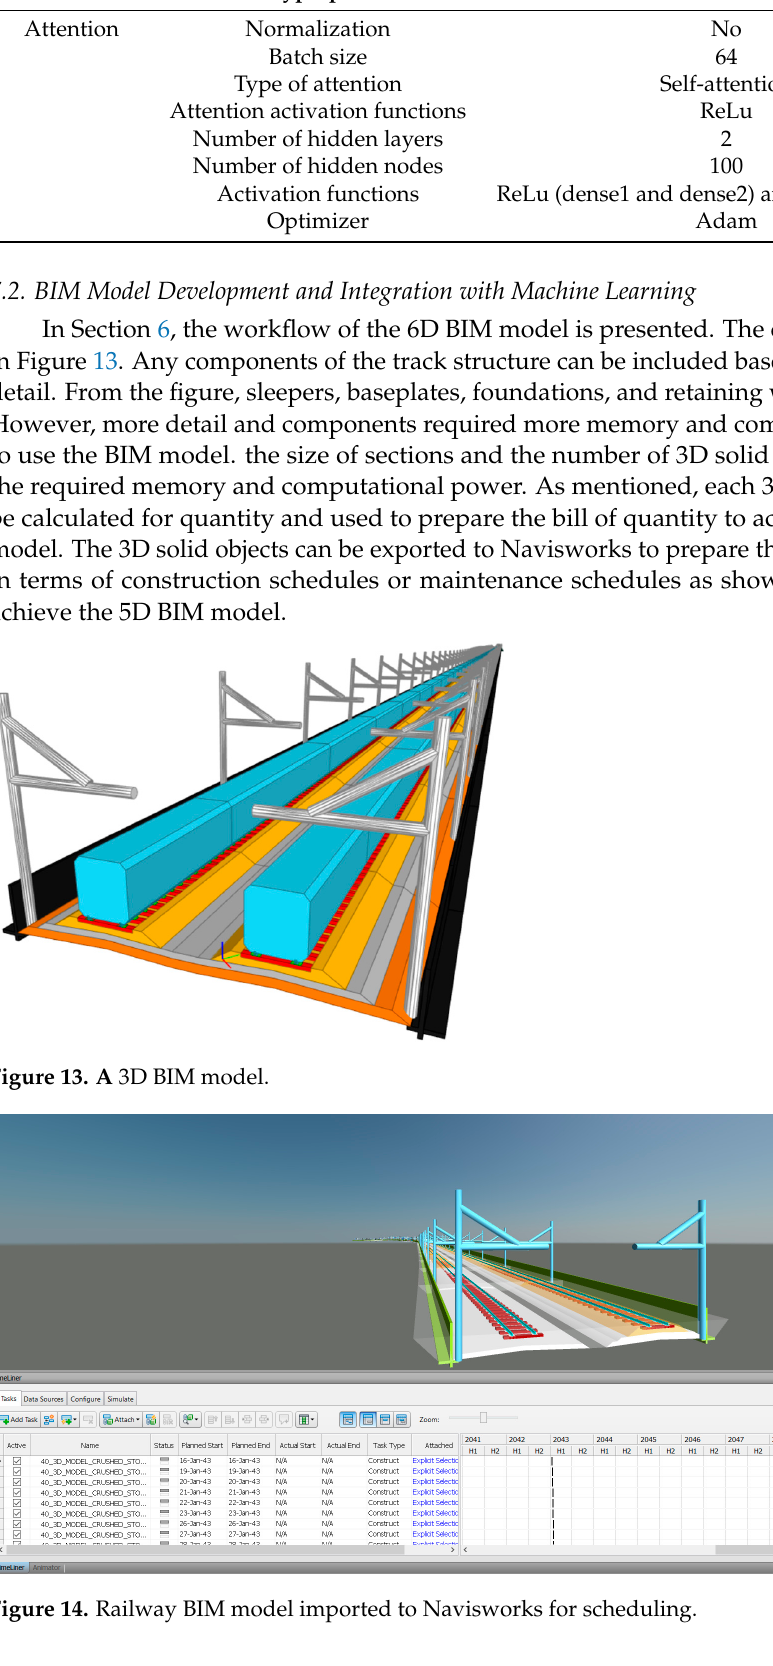
Figure 15. Information integrated into the BIM model. The developed 6D BIM model can be integrated with machine learning seamlessly and data exchange can be done automatically. The benefit of the developed BIM model, machine learning models, and workflow is they can be used together to predict each track geometry parameter and inform required maintenance responses to keep tracks in a good condition. Therefore, railway maintenance can be done more efficiently because it con- forms to the predictive maintenance concept.